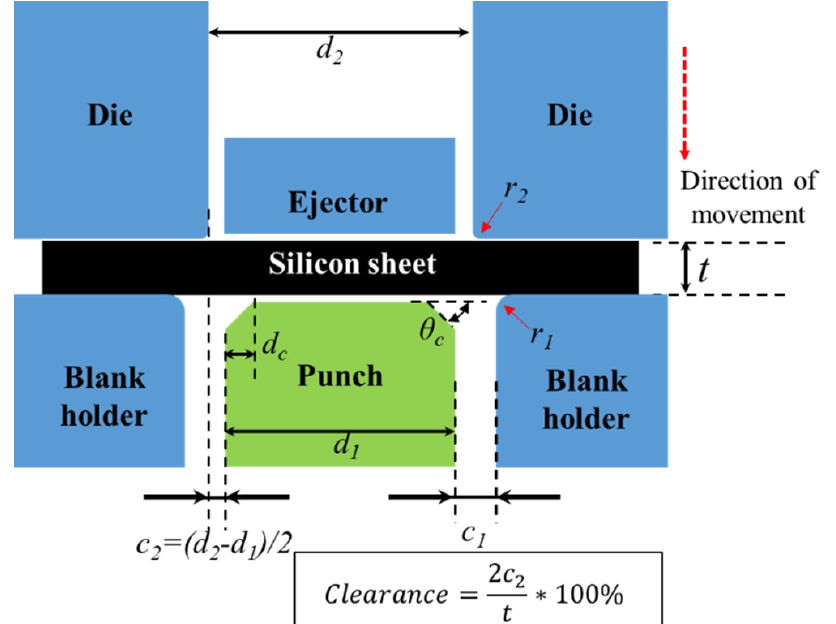
Figure 1. ( a ) GOS and grain size distributions of initial material. ( b ) Orientation distribution func- tion (ODF) section plot ( φ 2 = 45°) for initial material, and the dotted black line shows the ideal posi- tion of γ fiber.